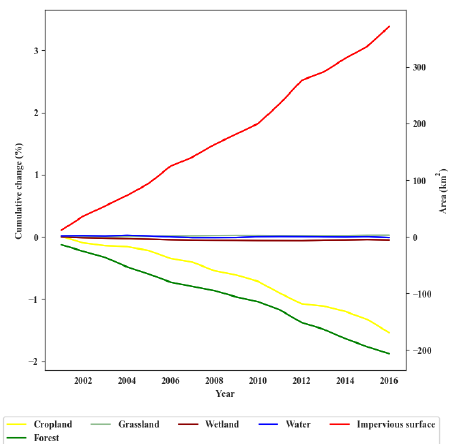
Figure 4. The cumulative LULC changes in area of various land covers between 2001 and 2017 for the total CZTUA. The impervious surface area increased from 808 km 2 to 1179 km 2 over the past 17 years with the net increase rate of 45.90% (Table A1). There was large spatial variation in the area of impervious surface increase among subregions: from 211 to 246 km 2 (16.59%) for Changsha City; 145 to 227 km 2 (56.55%) for Changsha County; 126 to 217 km 2 (72.22%) for Wangcheng District; 82 to 106 km 2 (29.27%) for Zhuzhou City; 31 to 64 km 2 (106.45%) for Zhuzhou County; 63 to 94 km 2 (49.21%) for Liling City; 83 to 103 km 2 (24.10%) for Xiangtan City; 57 to 110 km 2 (92.98%) for Xiangtan County; and 9 to 13 km 2 (44.44%) for Shaoshan City (Table A4). Figure 5 demonstrates the annual increment (AI) and annual growth rate (AGR) of the impervious surface for nine regions over the past 17 years. The AIs of impervious surface for Changsha County in the year of 2006, Wangcheng District in the year of 2011 and 2012, and Xiangtan County in the year of 2012 were the highest, which were greater than 10 km 2 in the observation. A very small decrease in impervious surface was also presented in Changsha City during the years from 2013 to 2015. The relatively low AIs of impervious surface were appeared in Shaoshan City, which was lower than 0.1 km 2 for most of the time. The AIs in the rest of the regions of CZTUA were increasing steadily. The highest AGR was presented in the Xiangtan county in 2012. AGRs in Changsha City, Xiangtan City, and Zhuzhou City became negative during certain periods. Zhuzhou County, Xiangtan County, and Wangcheng District had a relatively high AGR among the nine regions (Table A3).